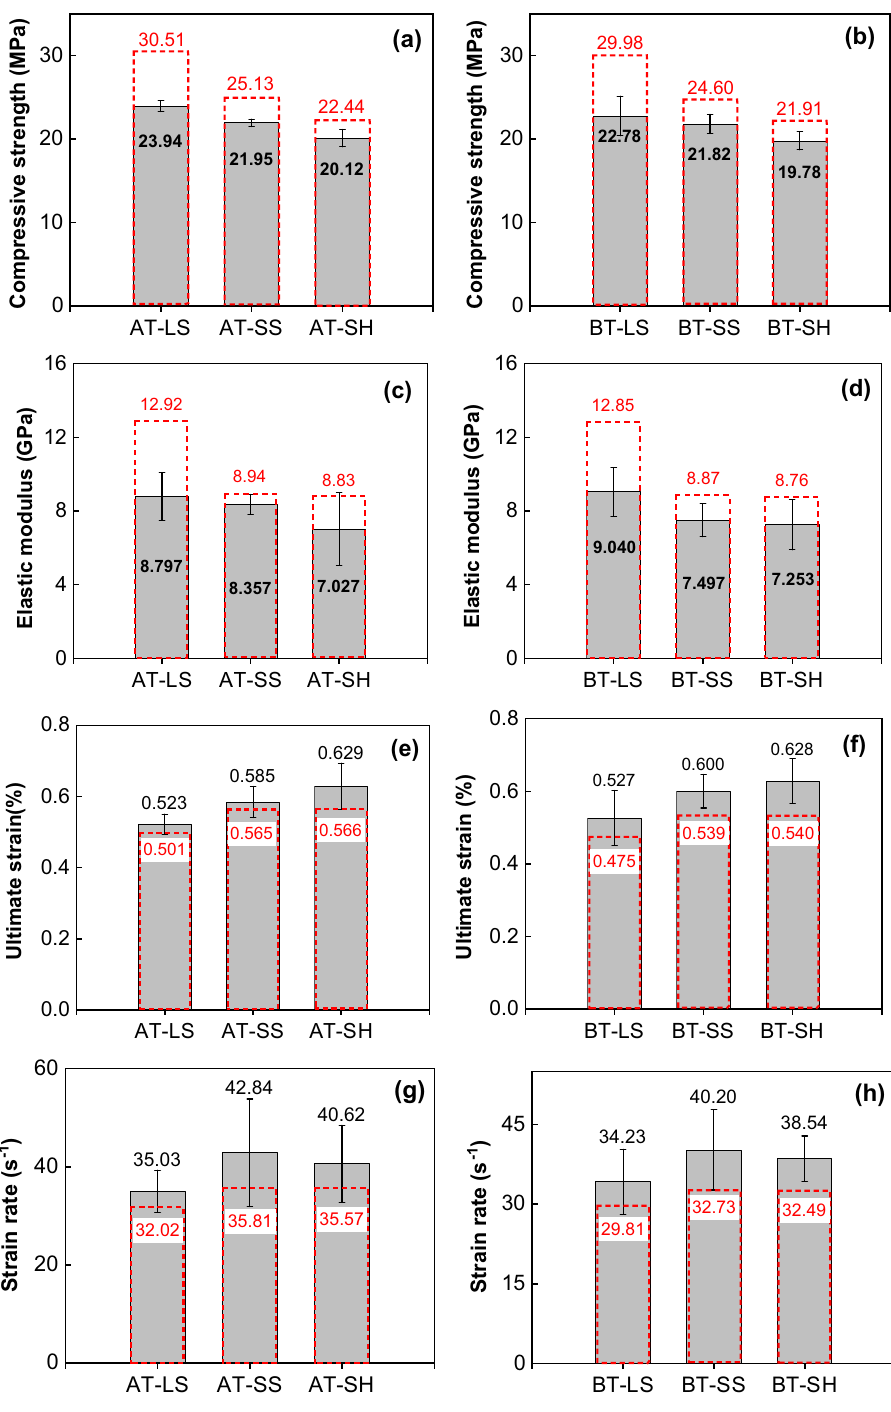
Figure 10. Dynamic mechanical parameters of different types of combined samples. Red dash rectangle represents the average value of single rock and coal, Gray dash rectangle represents the corresponding value of combined samples. AT-LS combined anthracite-limestone, AT-SS combined anthracite-sandstone, AT-SH combined anthracite-shale; BT-LS combined bituminous coal-limestone, BT-SS combined bituminous coal- sandstone, BT-SH combined bituminous